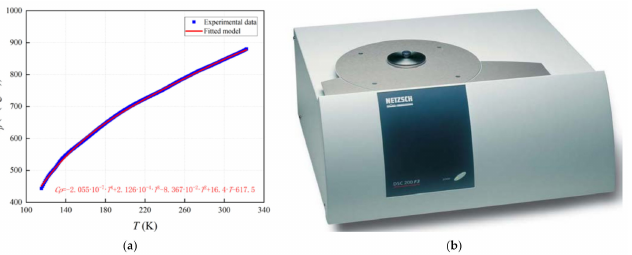
Figure 8. Specific heat capacity of the white cobbles by experiments ( a ) and the testing apparatus— NE-TZSCH DSC 200F3 ( b